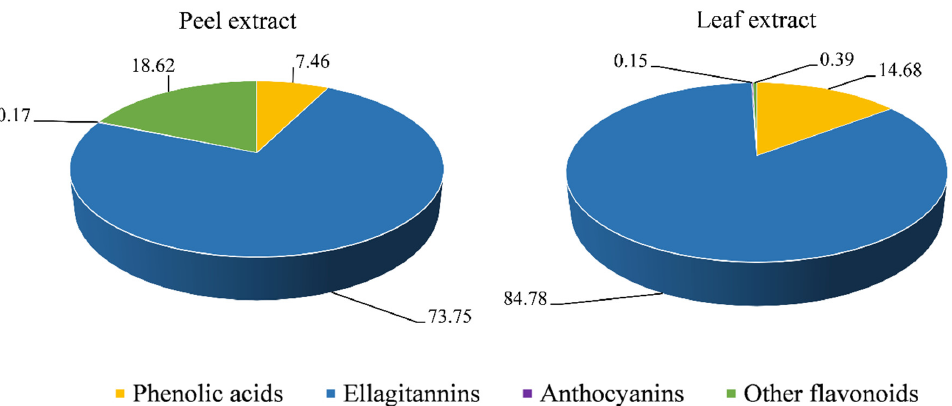
Figure 1. Main classes of polyphenols (%) identified and quantified in pomegranate peel and leaf extract by LC-PDA-ESI-MS analysis.